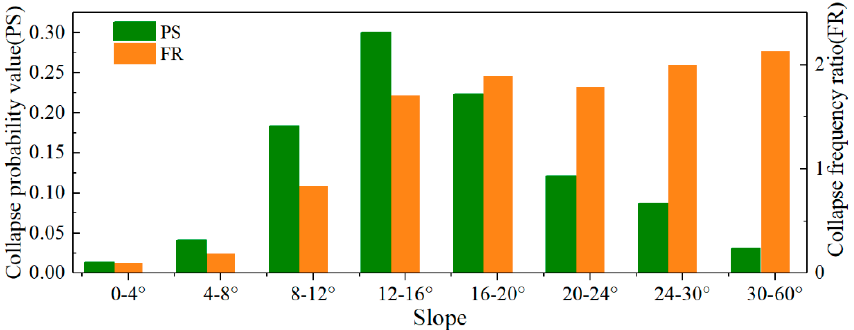
Figure 5. Effects of slope on collapse occurrence. Figure 5. E ff ects of slope on collapse occurrence.